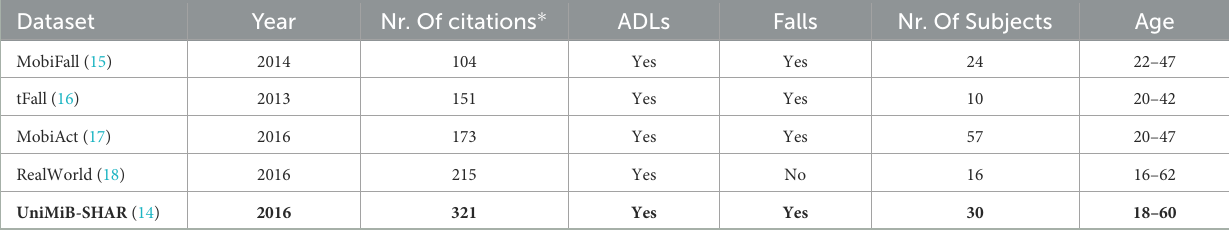
TABLE 1 Most popular datasets for human activity recognition and fall detection with accelerometer data.